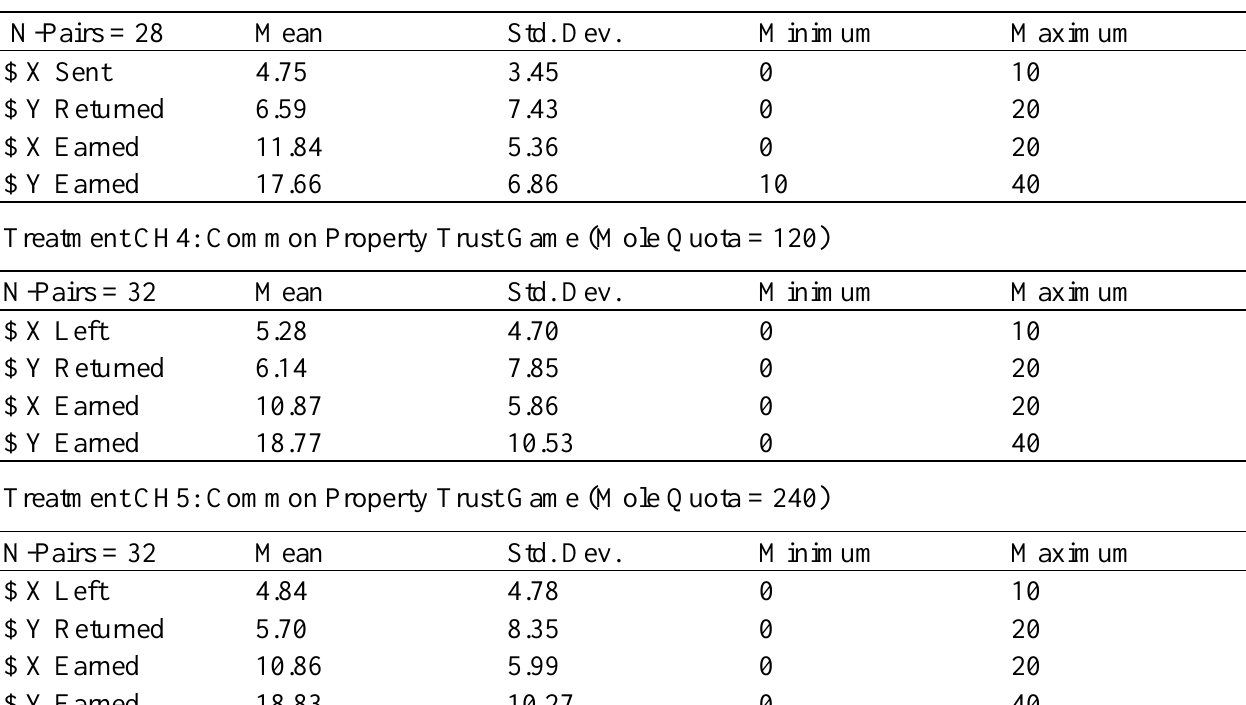
Table A4. Summary data for sequential move protocol Treatments CH3, CH4, and CH5. Treatment CH3: Private Property Trust Game (Mole Quota = 120)